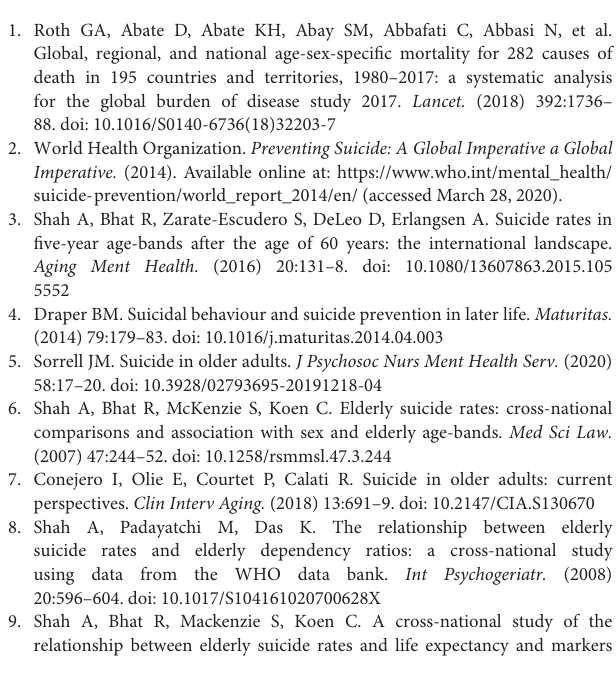
Supplementary Table 1 | Death numbers, mortality rates, and mortality fractions from suicide for people aged 70 and older, and their percentage changes between 1990 and 2017, in 195 countries and territories. Supplementary Table 2 | Mortality rates from suicide for the elderly (70+ years), age-standardized mortality rates from suicide for all ages, and their percentage differences, in 2017, for 21 GBD regions. Supplementary Table 3 | Mortality rates from suicide for the elderly (70+ years), age-standardized mortality rates from suicide for all ages, and their percentage differences, in 2017, for 195 countries and territories. Supplementary Table 4 | Percentage changes in mortality rates from suicide for the elderly (70 + years) between 1990 and 2017, percentage changes in age-standardized mortality rates from suicide for all ages between 1990 and 2017, and their differences, in 21 GBD regions. Supplementary Table 5 | Percentage changes in mortality rates from suicide for the elderly (70 + years) between 1990 and 2017, percentage changes in age-standardized mortality rates from suicide for all ages between 1990 and 2017, and their differences, in 195 countries and territories. Supplementary Table 6 | The orders and coefficients of ARIMA models for globe, sexes, 21 GBD regions, and 195 countries and territories. Supplementary Figure 1 | Differences between percentage changes in mortality rates from suicide for the elderly and percentage changes in age-standardized mortality rates from suicide for all ages between 1990 and 2017. Difference = P elderly − P std , where P elderly donates percentage change in mortality rate from suicide for the elderly between 1990 and 2017, and R std donates percentage change in age-standardized mortality rate from suicide for all ages between 1990 and 2017. Map was colored only for countries with decline in mortality rate from suicide for both the elderly and all ages, i.e., percentage change is less than zero. Supplementary Figure 2 | Relationship between SDI and elderly suicide mortality rates for each year. SDI = Socio-demographic Index. Models are weighted by the elderly population (point size). Y axes are shown after the square root transformation. Each point corresponds to the mortality rate for one of 195